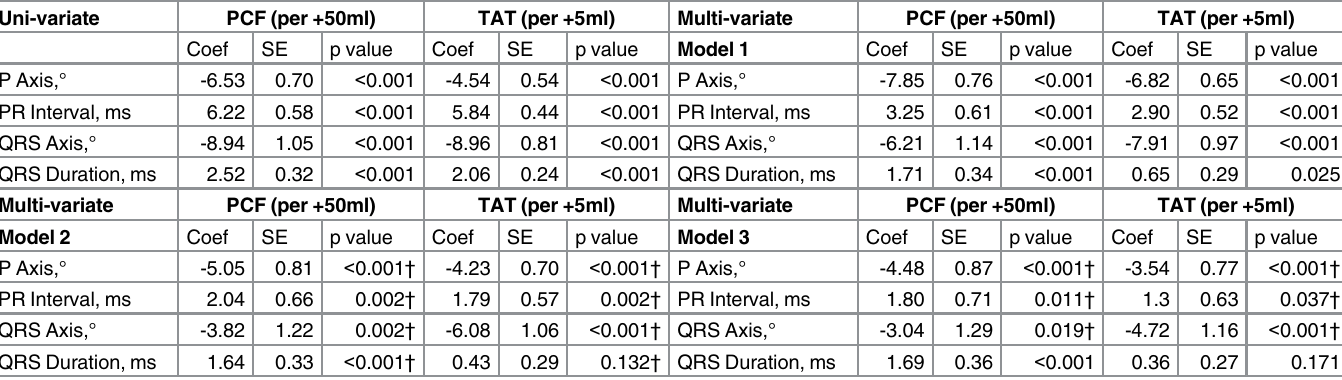
Model 1: adjusted for age, gender; Model 2: adjusted for age, gender, BMI; Model 3: adjusted for age, gender, BMI, SBP, Pulse rate, HDL, LDL, eGFR, hypertension, diabetes, cardiovascular disease, current smoking and alcohol use. † in which models BMI was signi fi cant (p < 0.05).